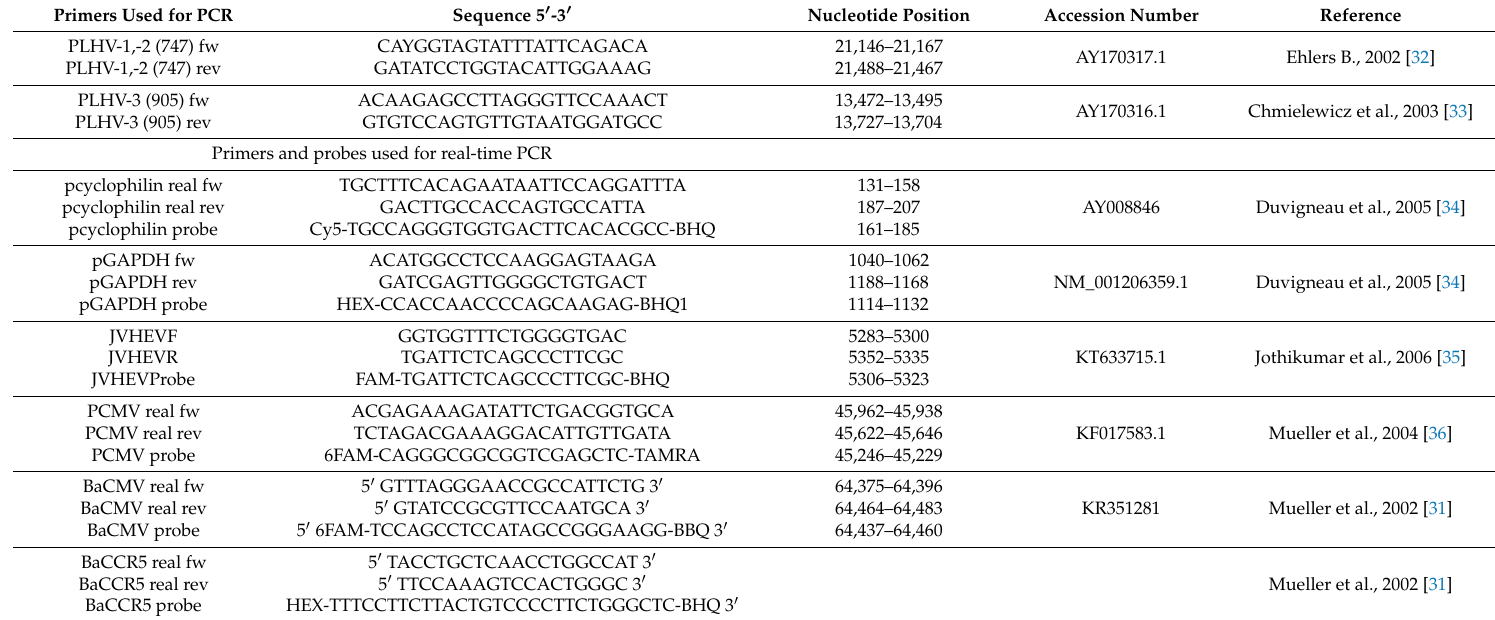
Table 1. Primers and probes used for real-time PCR. BaCMV: baboon cytomegalovirus; PLHV: porcine lymphotropic herpesviruses; PCMV: porcine